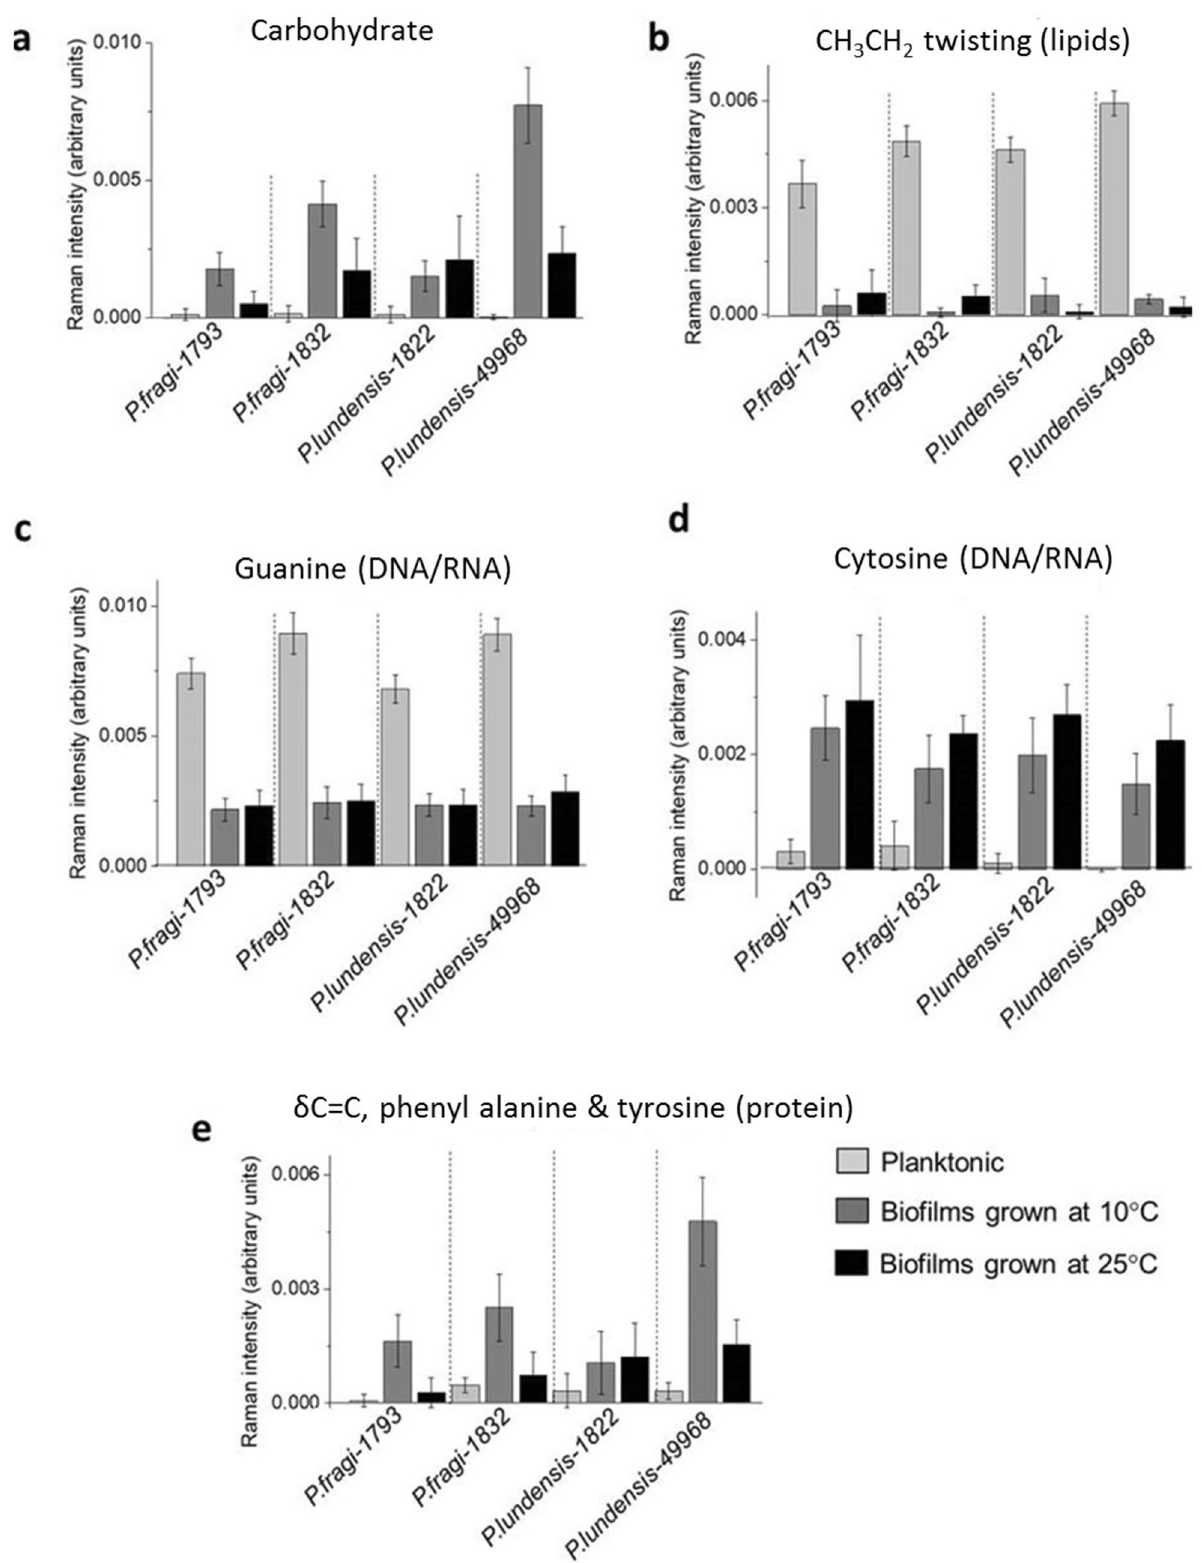
Figure 9. Specific peak analysis of the Raman spectra of planktonic and biofilms of the four bacterial strains. Univariate analysis was performed on the normalised intensity of carbohydrate ( a ), lipid ( b ), DNA/RNA ( c , d ) and protein ( e ) structure-specific peaks in the Raman spectra taken from planktonic and biofilm